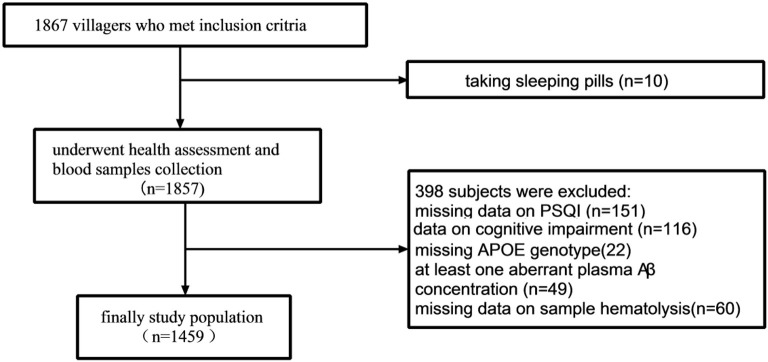
Flow chart of participant screening. Aβ, amyloid beta.